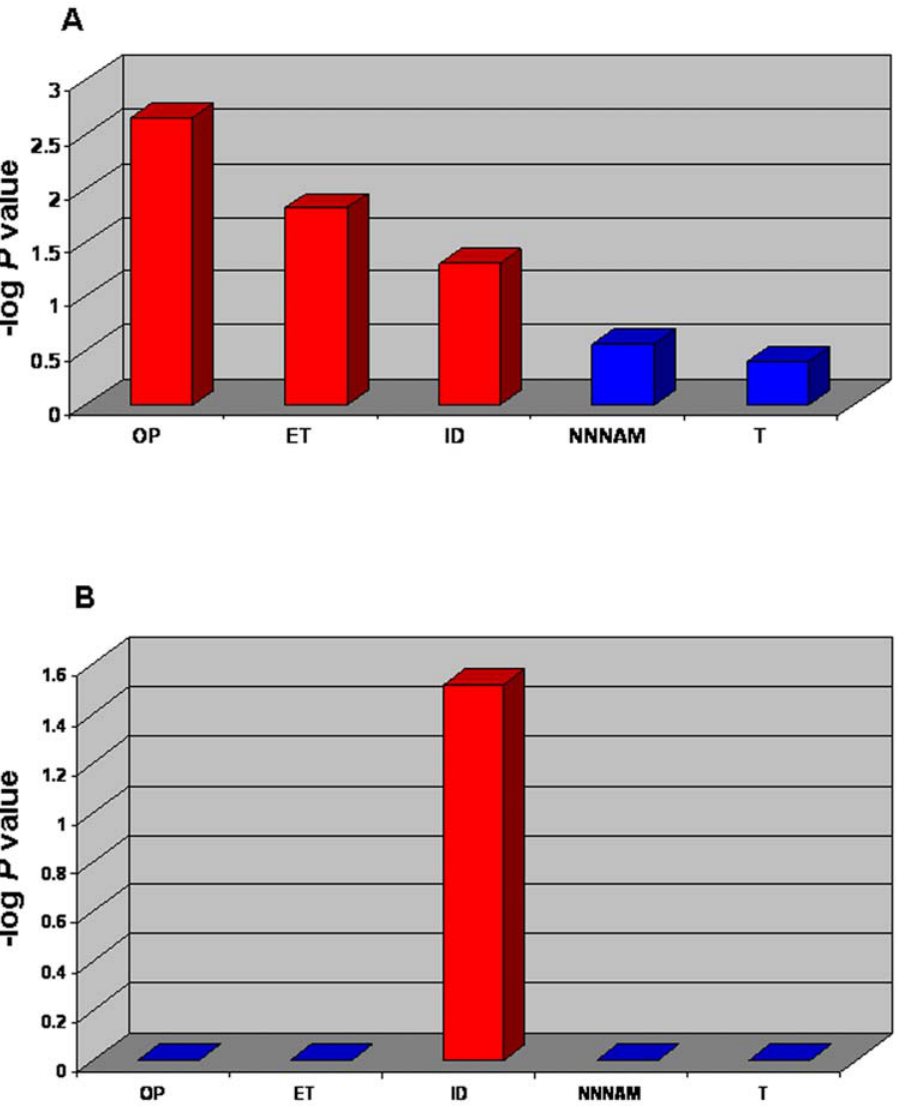
Figure 3. Gene ontology analysis of the most representative biological processes represented by the 101 up-regulated genes in RA patients. Gene Ontology (GO) analysis in the PANTHER database was applied for an interpretation of the biological processes that are represented by the genes showing a higher significantly different expression level in RA patients compared to the controls. A and B - Biological processes with a P value , 0.05 (red bars) were considered significant after Bonferroni correction. The GO analysis P -value was plotted on the y axis versus biological processes on the x axis. A - The binomial statistics tool was used to compare our gene list to a reference list (NCBI: Homo sapiens genes) determining the statistically significant ( P value) over- or under- representation of PANTHER biological process. B - The Mann-Whitney U Test was used to determine significant P values which indicate that the distribution (fold change) for each biological process is non-random and different from the overall distribution. OP - Oxidative Phosphorylation; ET - Electron Transport; ID - Immunity and Defense; NNNAM - Nucleoside, Nucleotide and Nucleic Acid Metabolism; T – Transport.